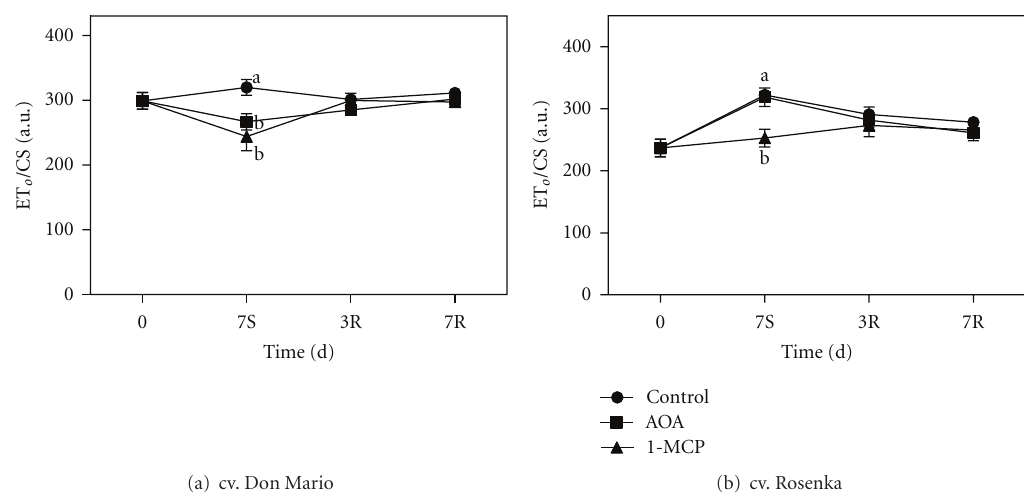
Figure 7: Electron transport flux per CS (ET o /CS) measured from leaves of cv. Don Mario (a) and cv. Rosenka (b) stored for 7 days (7S) at 14 ◦ C and transferred at 20 ◦ C for recovery evaluation (3R and 7R). Values are means with standard errors ( n = 10). Data were subjected to one-way ANOVA and di ff erent letters, when present, mean that values are statistically di ff erent P < 0 . 05.